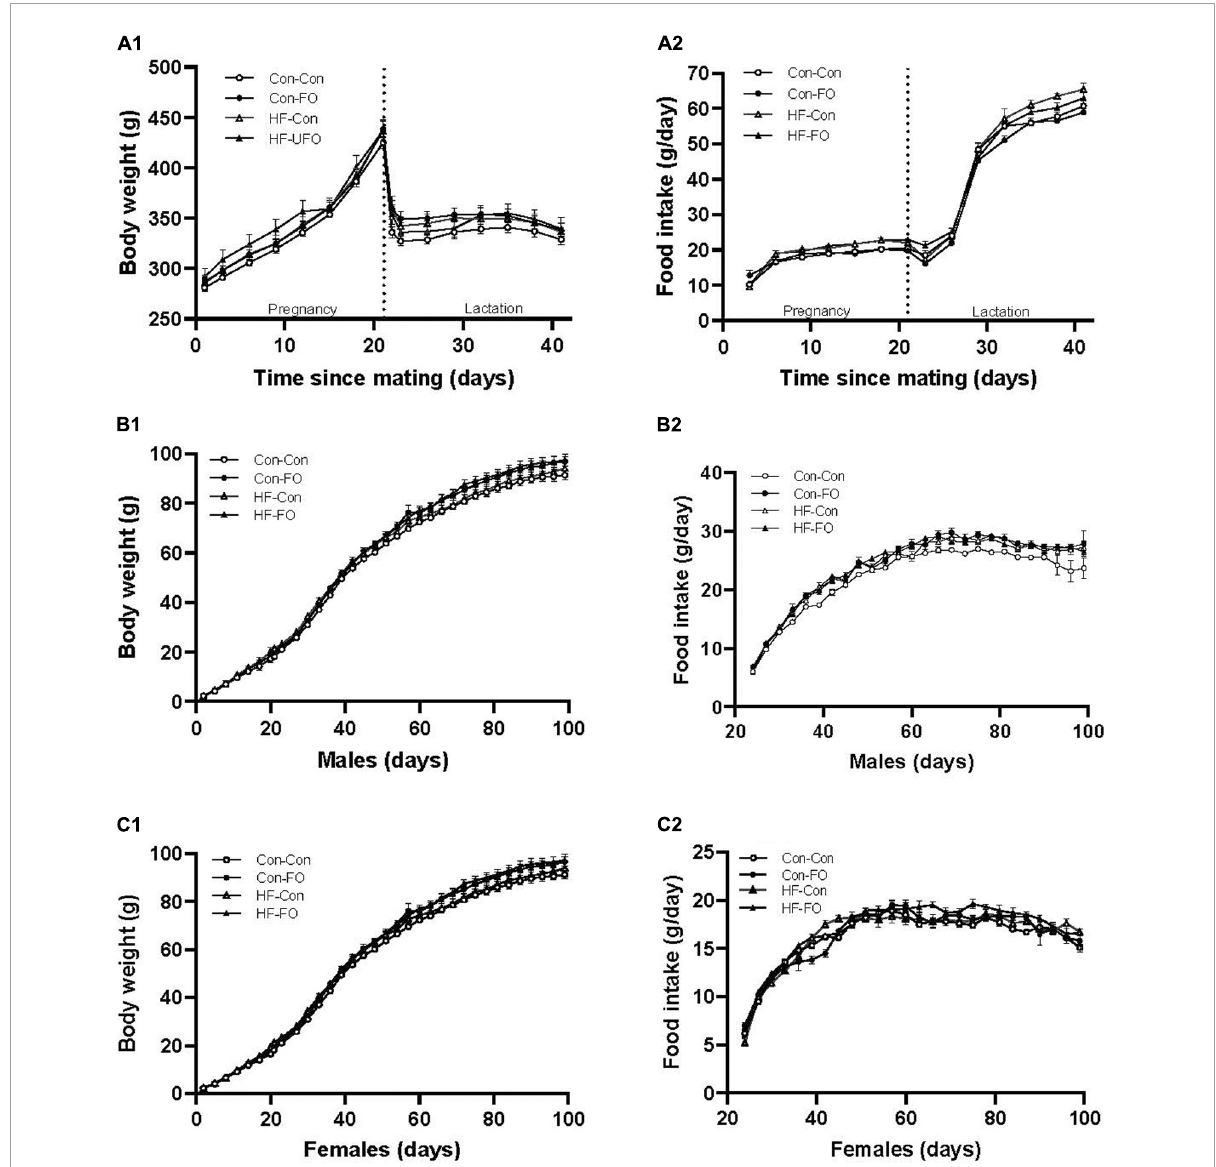
FIGURE2 Weight, food consumption, and energy intake in rat dams (A) , male (B) , and female offspring (C) according to the maternal diet (control or high-fat diet) and gel treatment during pregnancy [fish oil or control (no oil)]. (A) body weight (A1) , food consumption (A2) of dams from mating (day 0) through to weaning (day 42). (B) body weight (B1) , food consumption (B2) of male offspring from weaning through to adulthood (day 100). (C) body weight (C1) , food consumption (C2) of female offspring from weaning through to adulthood (day 100). Error bars represent standard